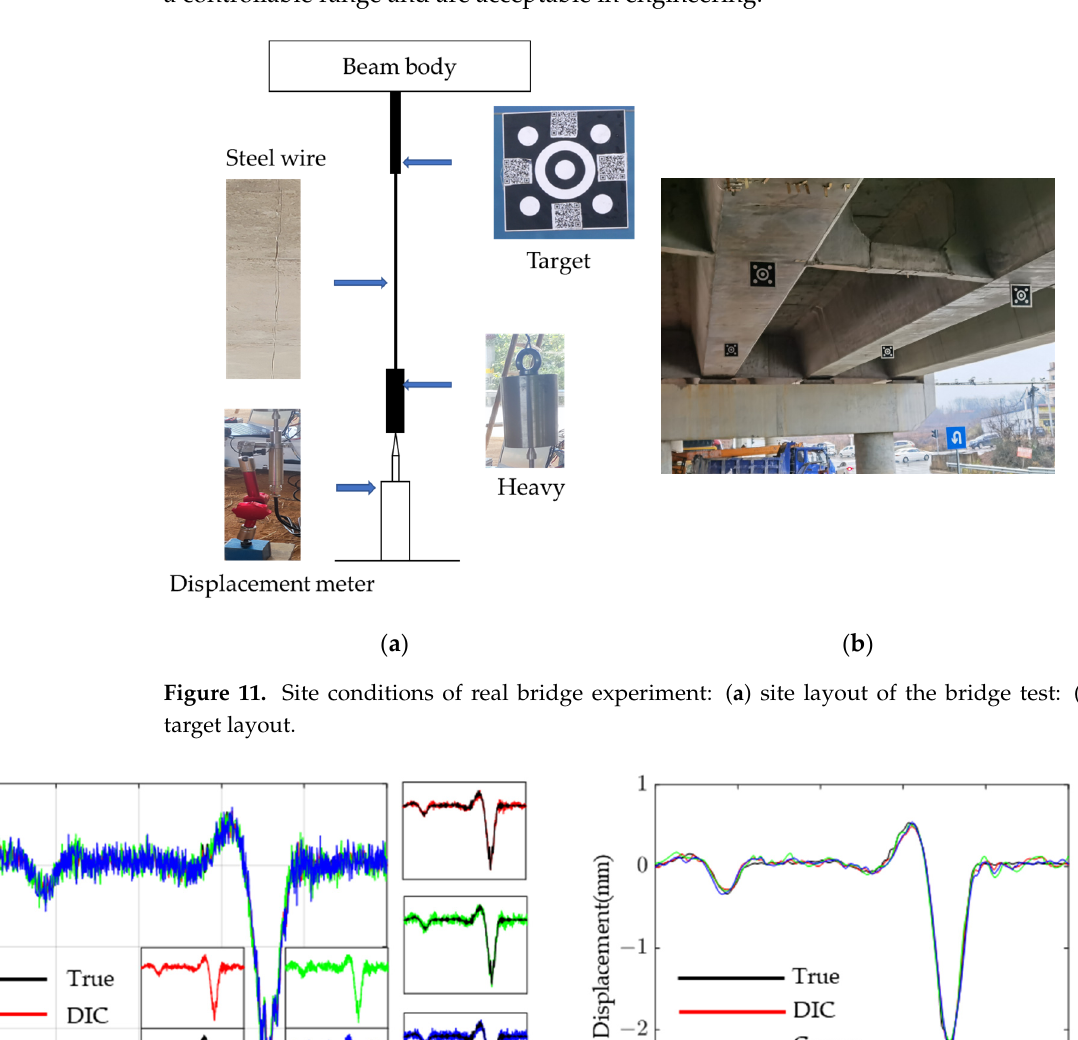
Figure 11. Site conditions of real bridge experiment: ( a ) site layout of the bridge test: ( b ) site target layout. Table 1. List of hardware equipment used in the real bridge test.